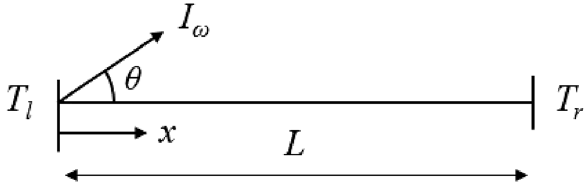
Figure 1. Numerical analysis domain of the one-dimensional